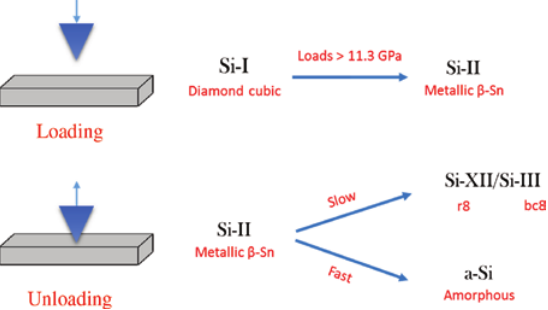
Figure 10: Phase transformations of silicon during nanoindentation procedure depending on maximum load and loading/unloading